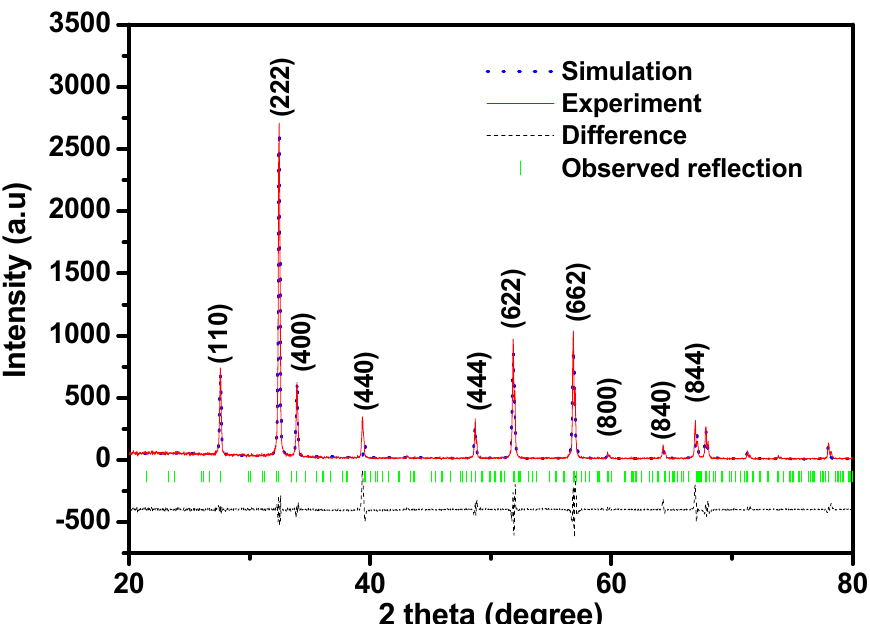
Figure 2. X − ray powder diffraction (XRD) patterns and Rietveld refinements of In 2 CdO 4 (red solid line represents experimental XRD data of In 2 CdO 4 ; blue dotted line represents simulated XRD data of In 2 CdO 4 ; black dotted line represents the difference between experimental and simulated XRD data of In 2 CdO 4 ; green vertical line represents observed reflection positions).